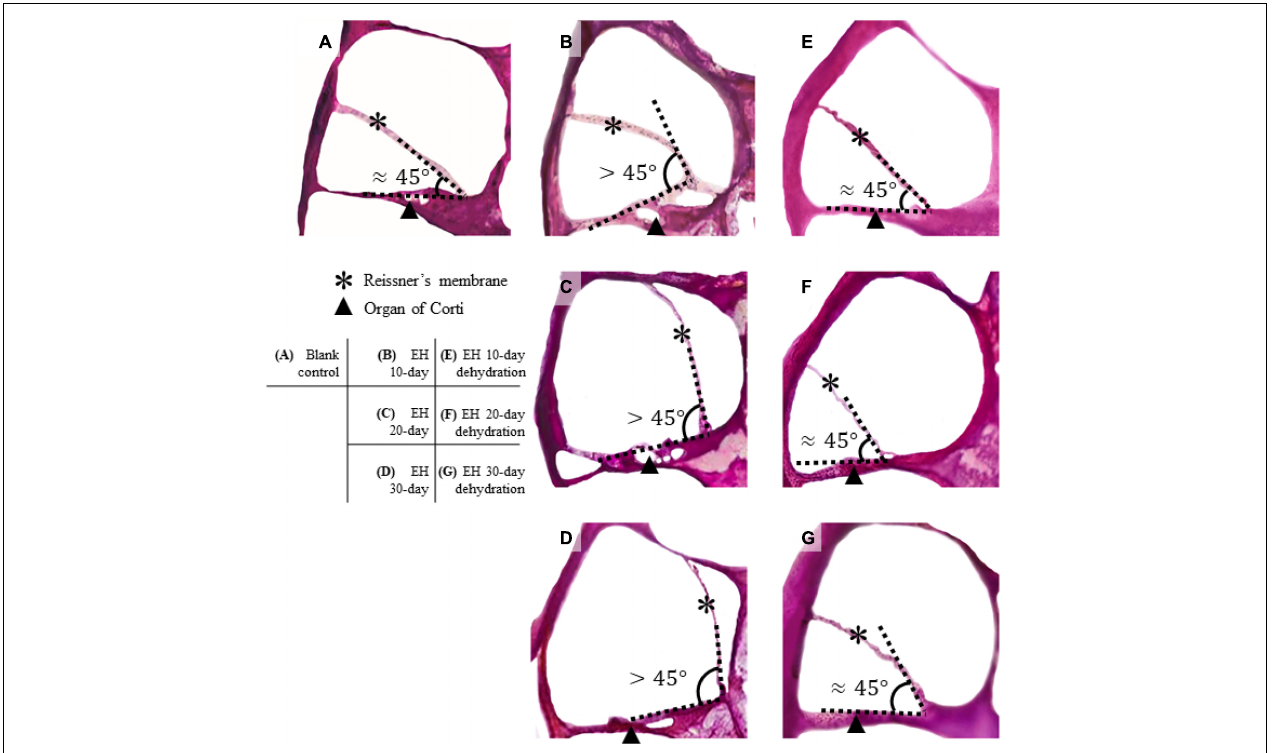
FIGURE 3 | Section of cochlear turn 2 of normal, EH-modeled, and dehydration-treated guinea pigs. In the control group (A) , the Reissner’s membrane (RM) and the organ of Corti are in the normal position, and the RM and BM form a sharp angle (approximately 45 ◦ ). In the EH groups (B–D) , the RM are bent, and the